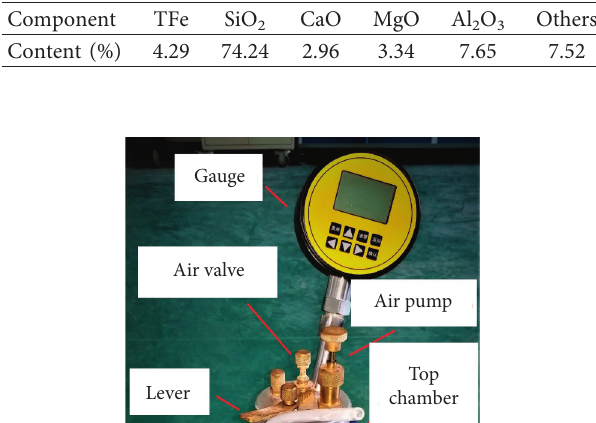
Figure 1: Particle size distribution curve of full tailings. Table 1: Chemical composition of full tailings